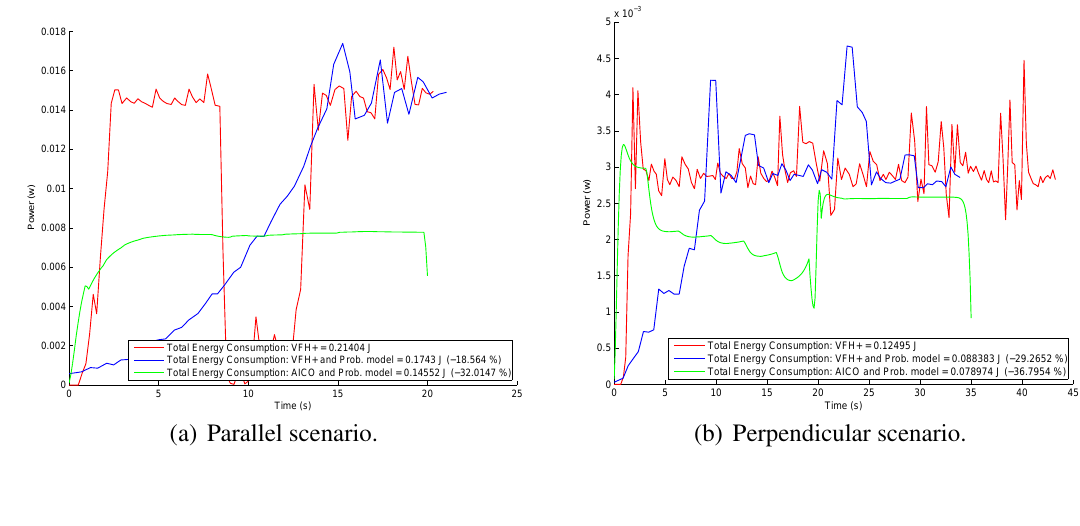
Figure 12. Energy consumption using VFH+